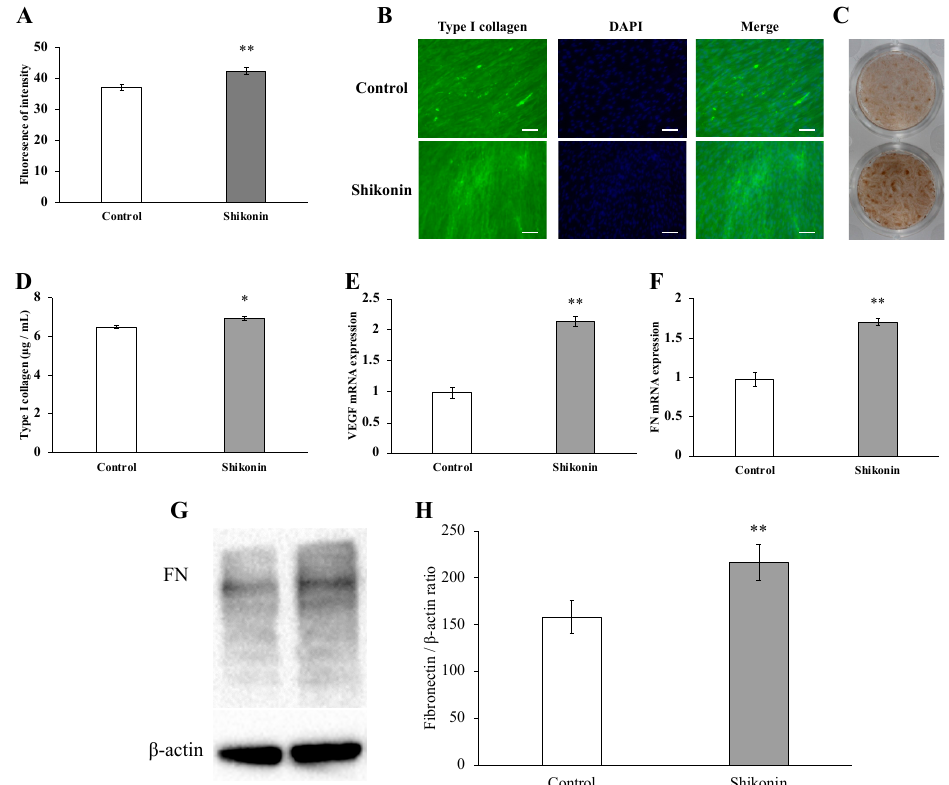
Figure 3. Type I collagen synthesis by human gingival fibroblasts (hGF) treated with or without 1 µ M shikonin. Immunostaining for type I collagen using an anti-type I collagen monoclonal antibody. ( A ) Intensity of fluorescence immunostaining without (control) or with shikonin (** p < 0.01 vs. control). ( B ) Cells were incubated with fluorescently labeled secondary antibody and stained with DAPI (scale bar= 500 μ m). ( C ) After incubation of the cells with the secondary antibody, chromogenic immunostaining was performed, and images were obtained by using a single-lens reflex camera. ( D ) Type I collagen in the cell culture supernatant after treatment for 1 week was measured by using ELISA. (* p < 0.05, control vs. 1 μ M shikonin). ( E , F ) Effects of shikonin on the gene expression of VEGF and FN in stimulated hGFs incubated with 1 μ M shikonin for 24 h prior to cell harvest. The gene expression of VEGF and FN was determined by using PCR. (** p < 0.01, control vs. 1 μ M shikonin). ( G ) Protein expression of FN was evaluated by immunoblotting analysis. ( H ) The quantification was performed using image analysis software. (** p < 0.01 vs. control).